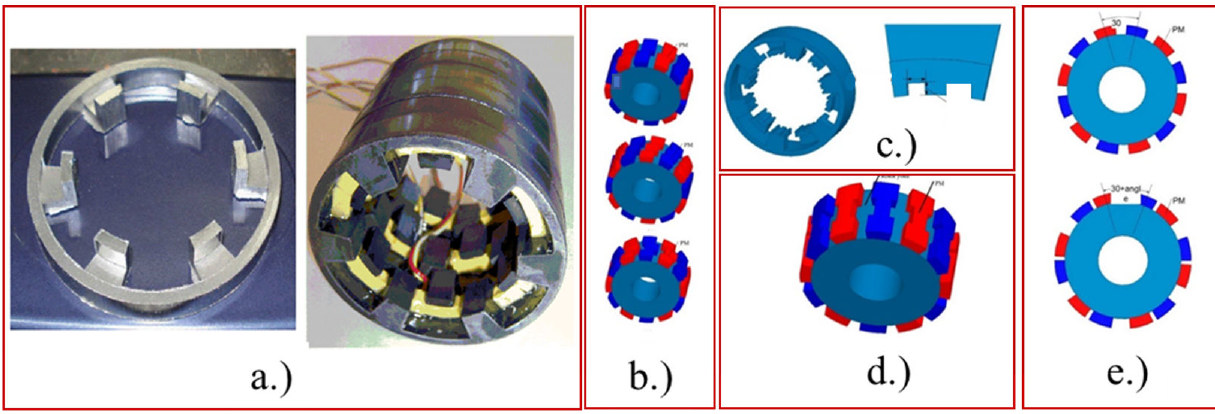
Figure 14. ( a ) Molded stator of three phase CPM [112] ( b ) Magnet Skewing [115] ( c ) Claw-pole shaping & stator tooth notching [113] ( d ) Magnet axial pairing [113] ( e ) Magnet Shifting [113].